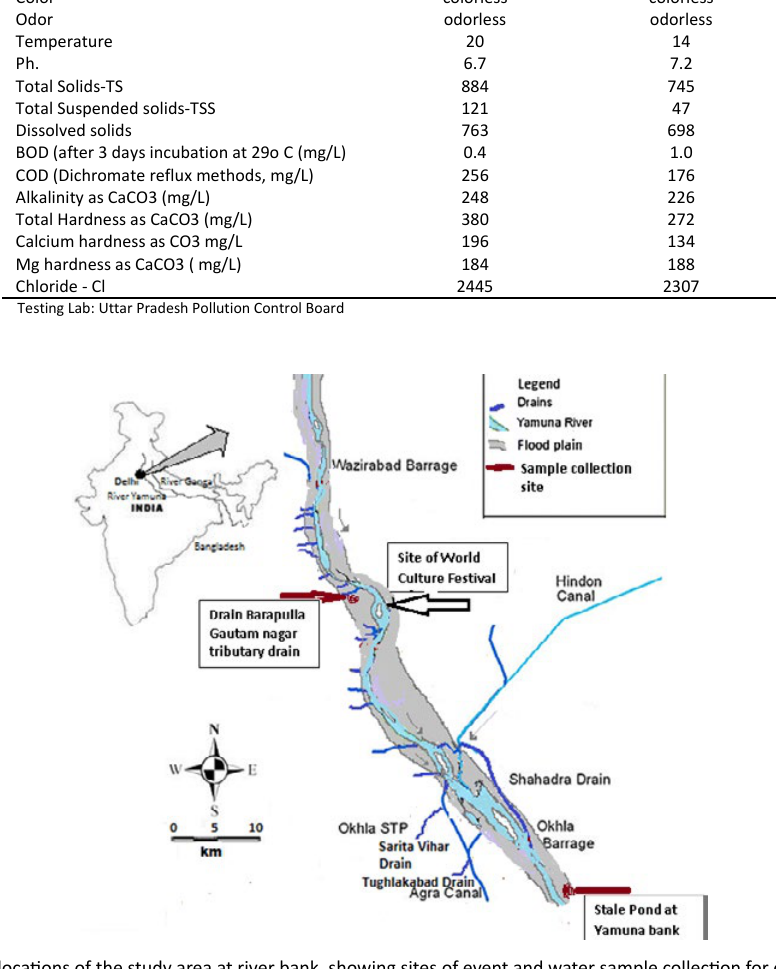
Table 3. Water quality parameters Pre and Post eco ‐ enzyme to pond water Pre enzyme treatment on Parameters tested 04.10.17